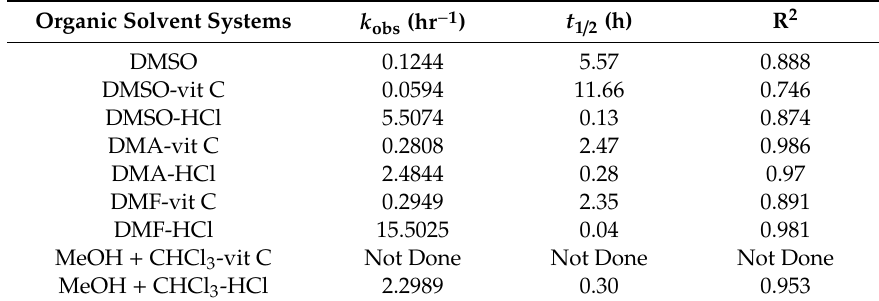
Table 1. The pseudo-first-order rate constants ( k obs ) and half-life ( t 1/2 ) values of AmB in different organic solvent systems.